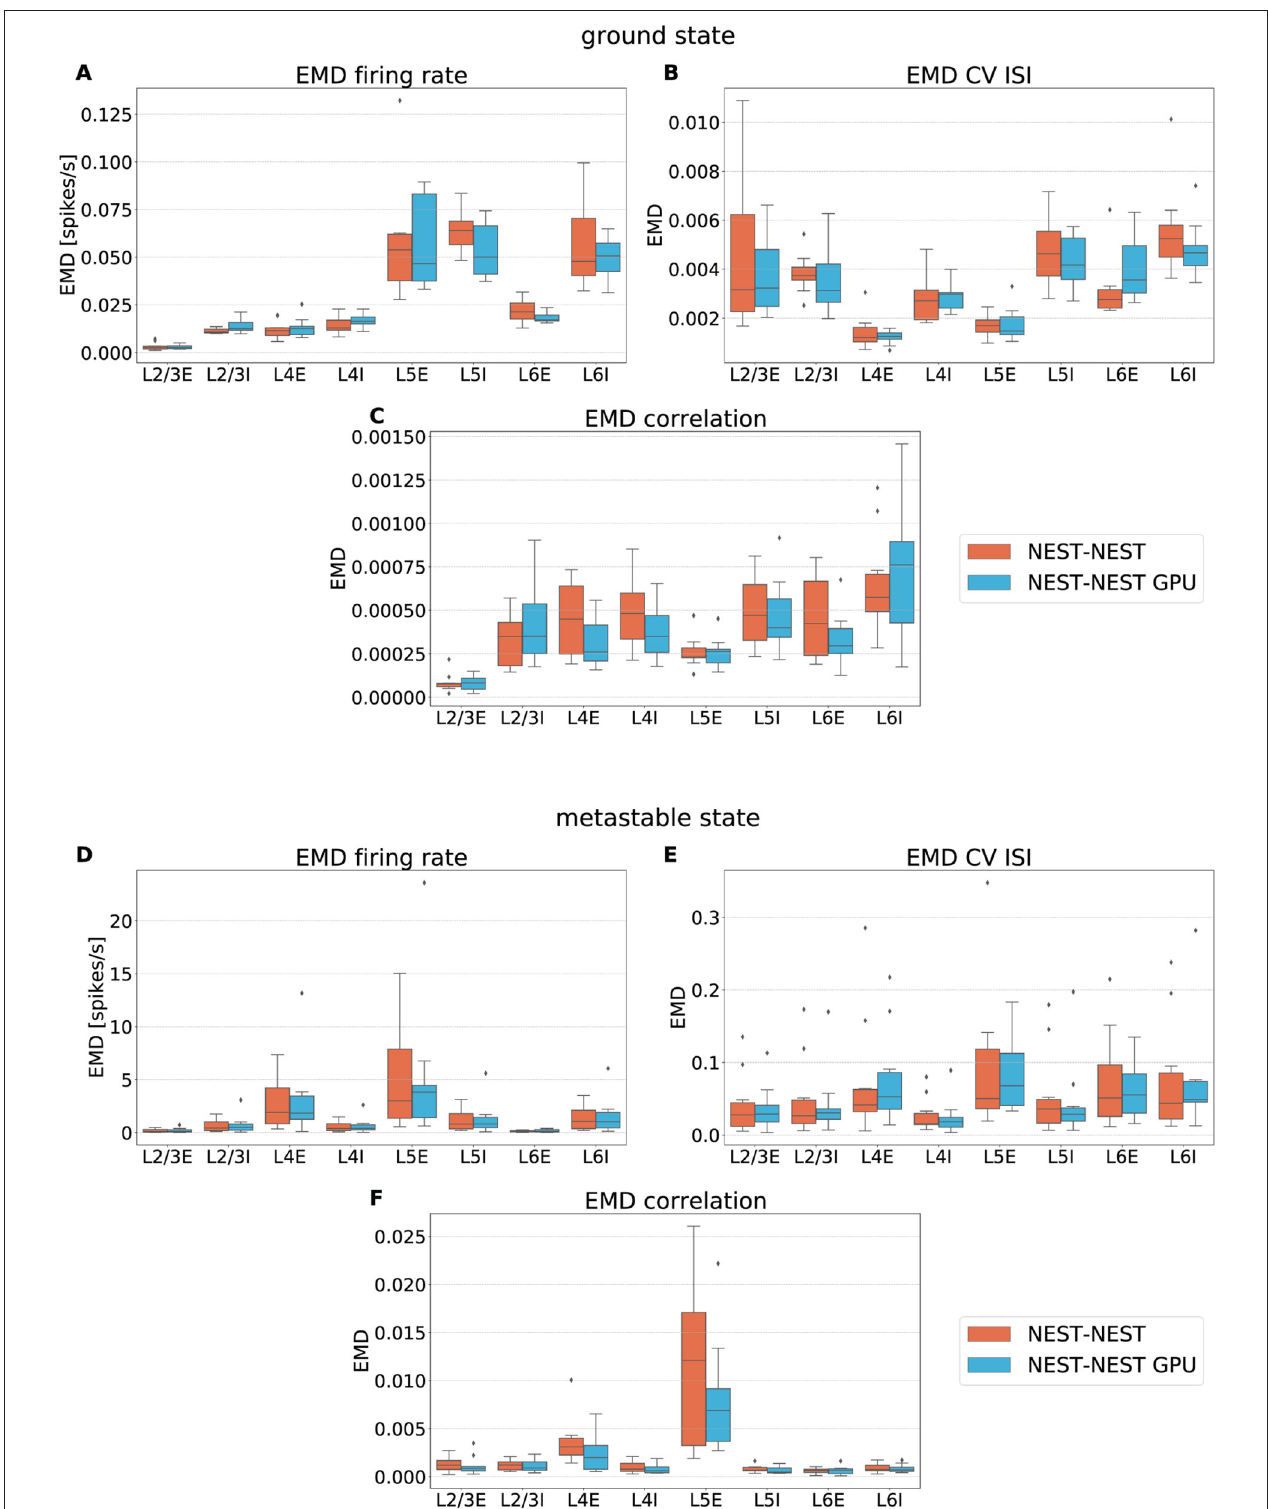
FIGURE 6 | Earth Mover’s Distance between distributions of firing rate (A,D) , CV ISI (B,E) and correlation of the spike trains (C,F) obtained for area V1 of the model in the ground state and the metastable state. NEST-NEST (orange, left) and NEST-NEST GPU (sky blue, right) data are placed side by side.